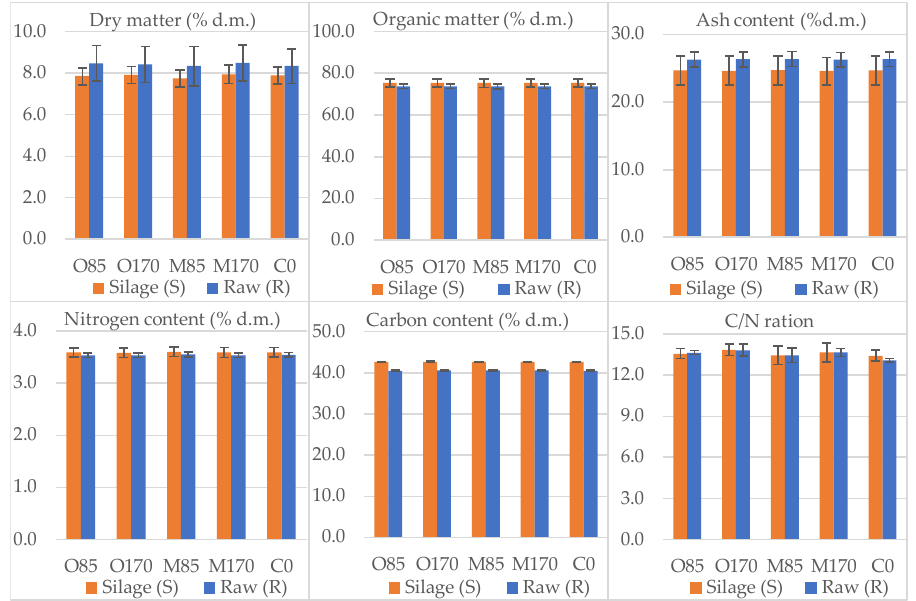
Figure 2. Characteristics of the mixture of substrate silage/raw material/ of Helianthus salicifolius and anaerobic sludge used for the anaerobic digestion test (C0—without fertilization; M85—mineral fertilization 85 kg N ha − 1 ; M170—mineral fertilization 170 kg N ha − 1 ; O85—organic fertilization 85 kg N ha − 1 ; O170—organic fertilization 170 kg N ha − 1 ). Table 4. The Pearson correlation coefficients for the analyzed traits.